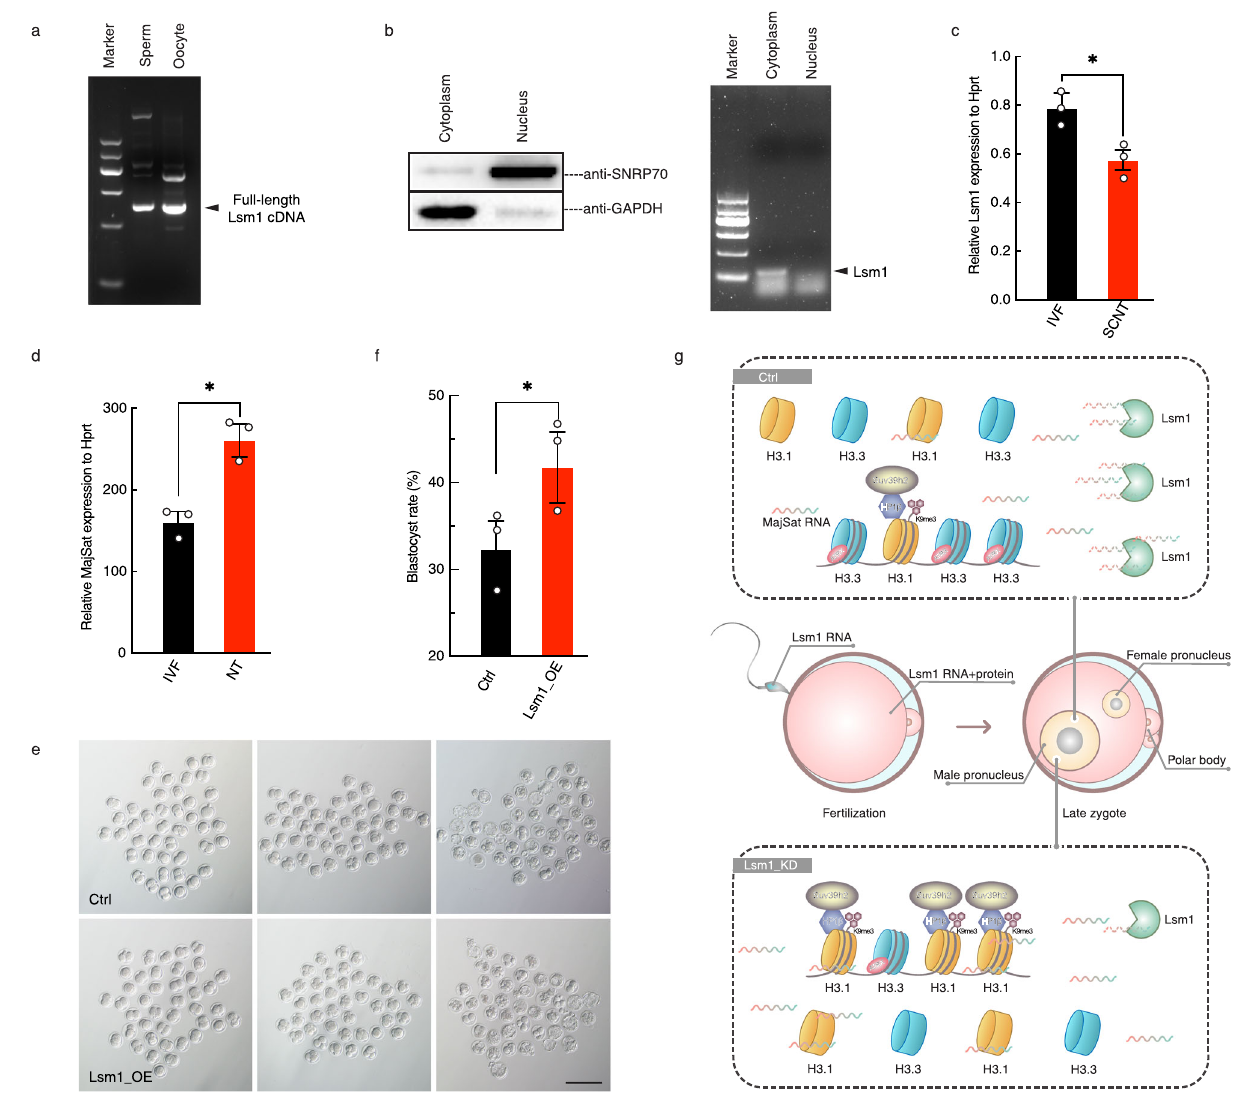
Fig. 6 | Lsm1 originates from both gametes and helps establish totipotency. a Agarose gel electrophoresis of RT – PCR ampli fi cation of full-length Lsm1 mRNA from sperm and oocytes. Representative images from 3 biological replicates. b AgarosegelelectrophoresisofRT – PCRdetectionofLsm1mRNAfromcytoplasm and nucleus of somatic cells. Representative images from 3 biological replicates. c Lsm1 mRNA levels between IVF and SCNT zygotes as quanti fi ed by qPCR. The statistical data are expressed as mean±SEM, * p <0.05 ( p =0.0409) by two-sided Student ’ s t test for each comparison. Each reaction for qPCR analysis contains 3 biological replicates, with each replicate from 50 zygotes. d MajSat RNA level between IVF and SCNT zygotes as quanti fi ed by qPCR. The statistical data are expressed as mean±SEM, * p <0.05 ( p =0.0137) by two-sided Student ’ s t test